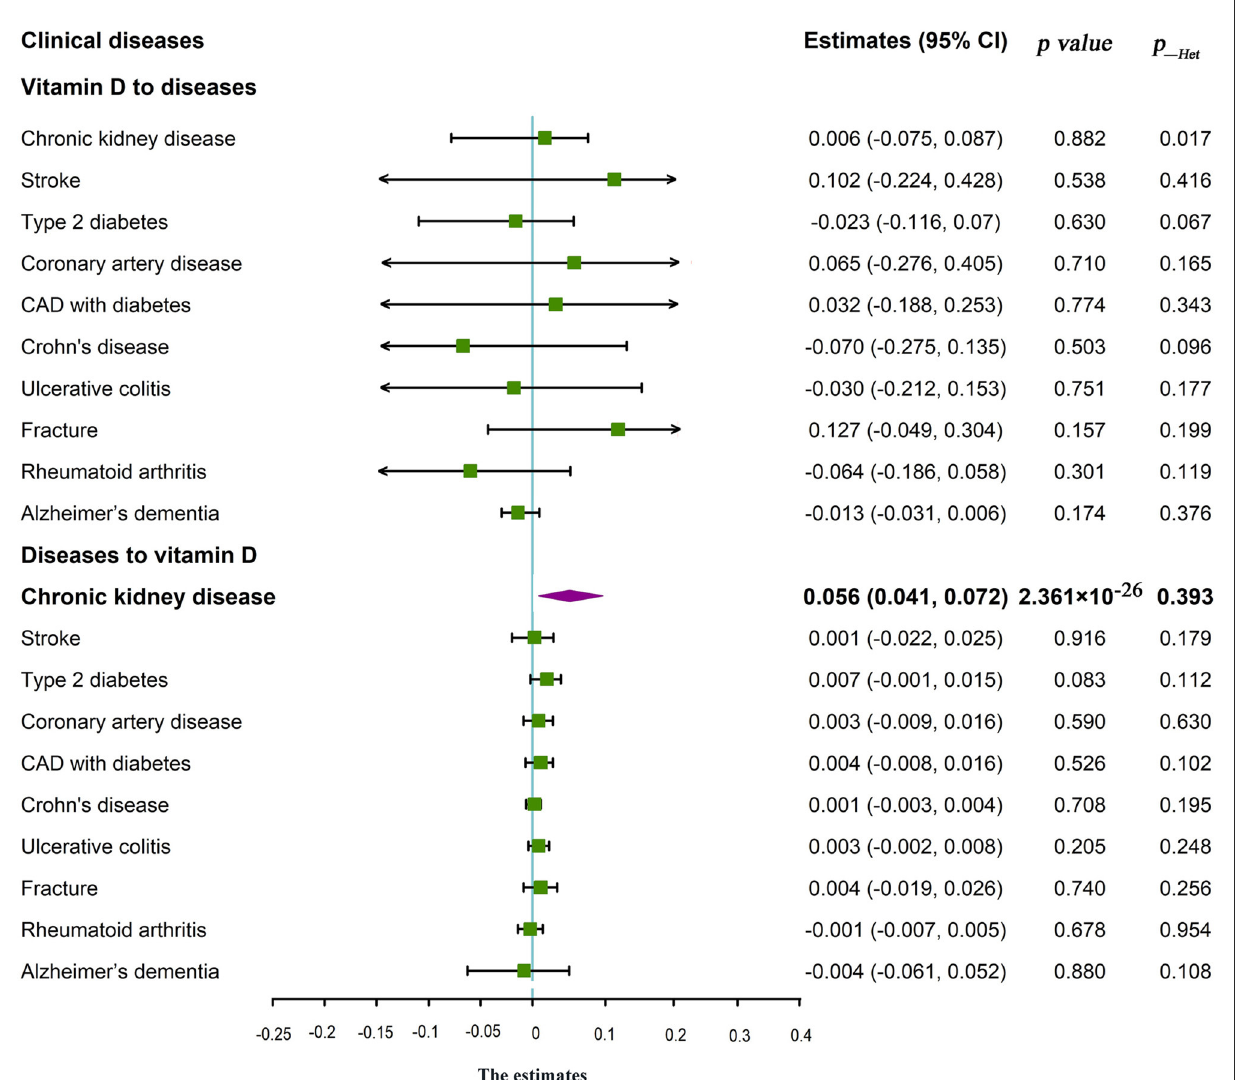
FIGURE1 Forest plot of the association between circulating 25(OH)D and clinical diseases in bidirectional Mendelian randomization analysis. CAD, coronary artery disease; p _Het, heterogeneity statistics.